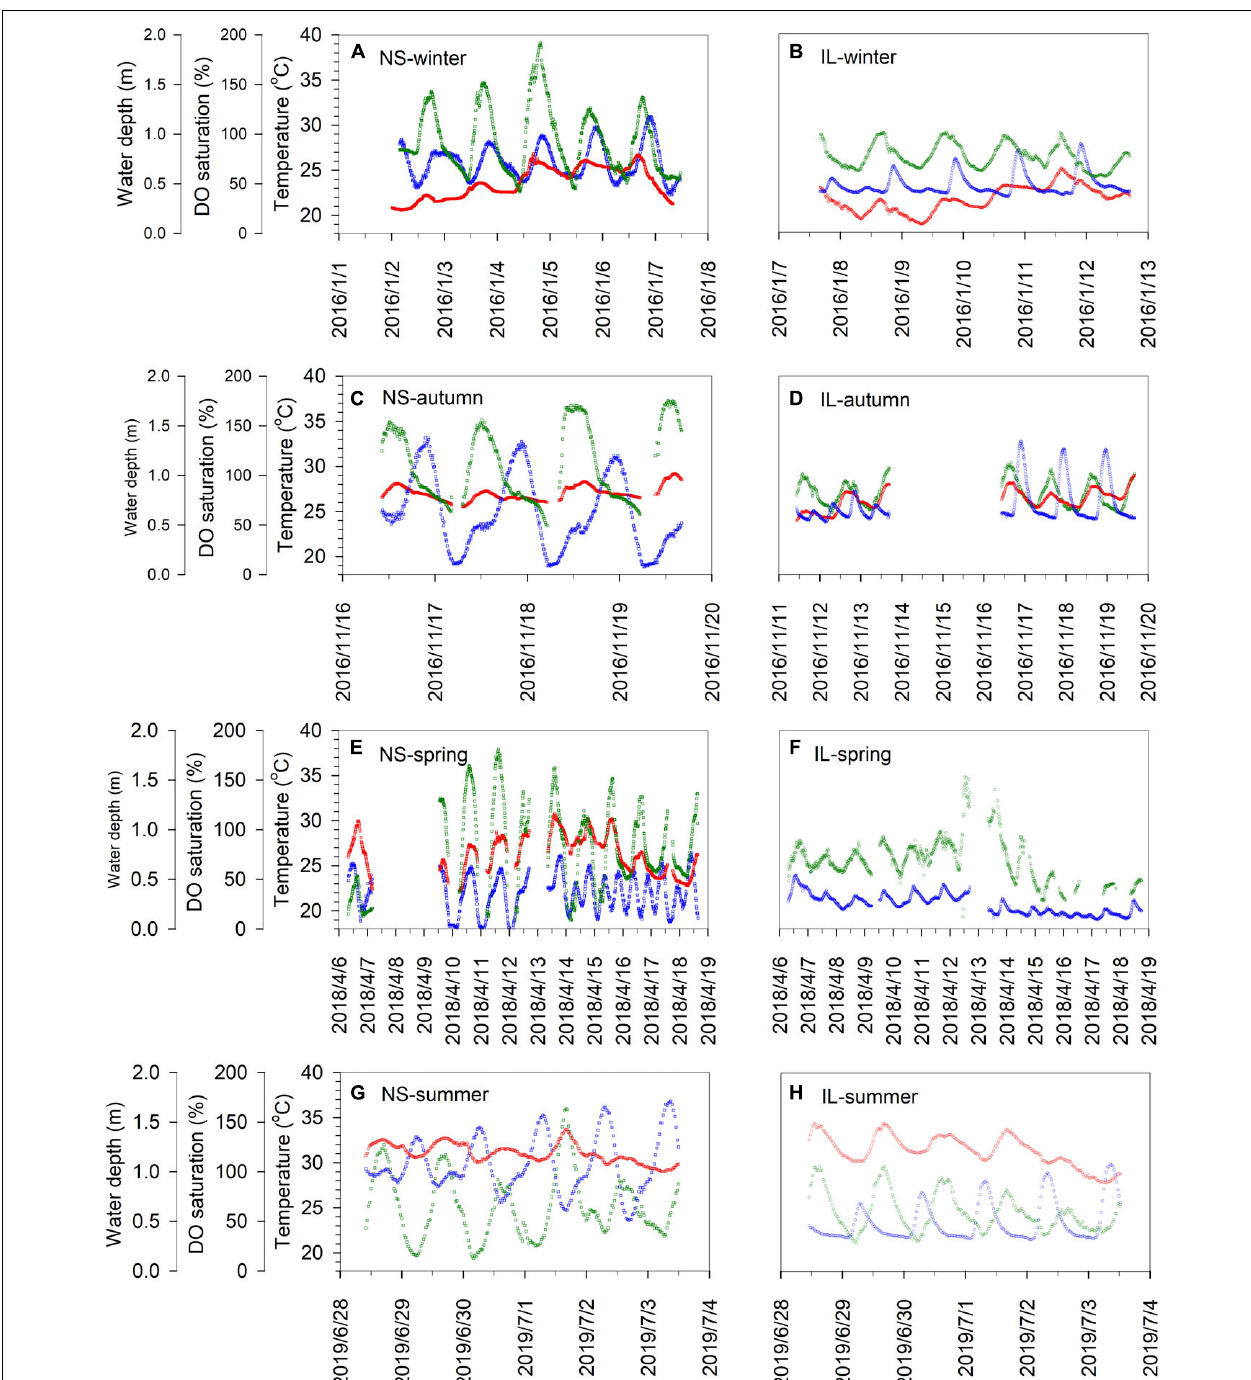
FIGURE 5 | Seasonal time-series observations of temperature (red symbols), water depth (red symbols), and DO saturation (red symbols) in the inner lagoon (IL, right panels; B,D,F,H ) and on the northern shore (NS, left panels; A,C,E,G ) of Dongsha